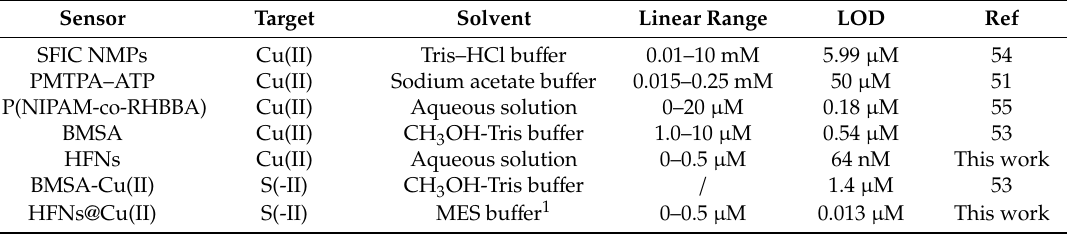
Table 4. Comparison of some fluorescence sensors for the determination of Cu(II) and S(-II).